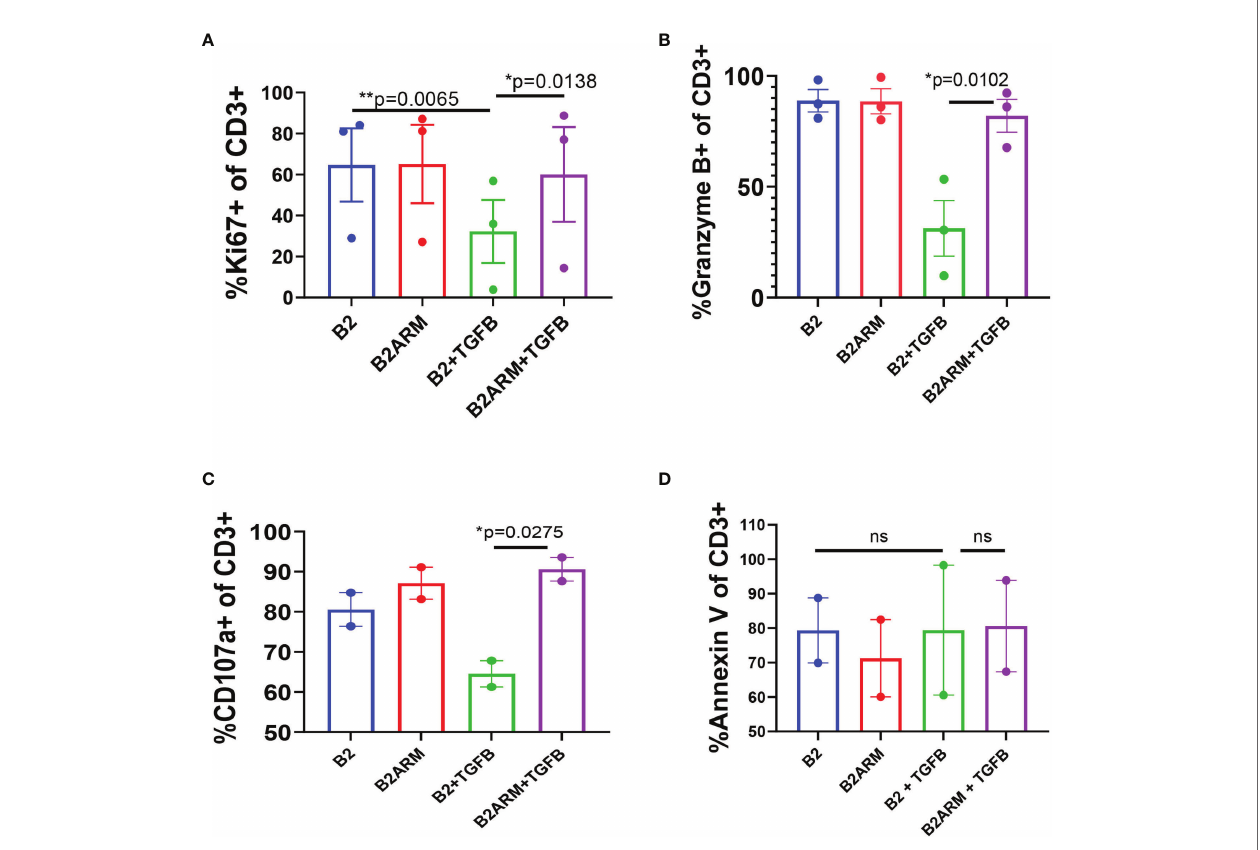
FIGURE 4 | The armored B2ARM CAR maintains normal proliferative and degranulation capacity following long-term exposure to TGF- b , in contract to the non- armored CAR B2. Long-term co-cultures with target cells, MM.1S-GFP was achieved by repeatedly restimulating the co-cultured CAR T cells with target cells at ETT ratio of 0.1. Percentage expression of proliferation marker Ki67 (A) , degranulation markers granzyme B and CD107a (B, C) , respectively, as well as the apoptotic marker annexin V (D) , by CAR T cells were evaluated by fl ow cytometry at the end of the long-term co-cultures (days 8-10). Total CD3+ cells were acquired by fl ow cytometry for analysis. Results represent mean ± SEM from 2 or 3 separate donors. Statistical signi fi cance was determined by one way ANOVA with Tukey ’ s post- hoc test.*p<0.05, **p<0.01, ns-non-speci fi